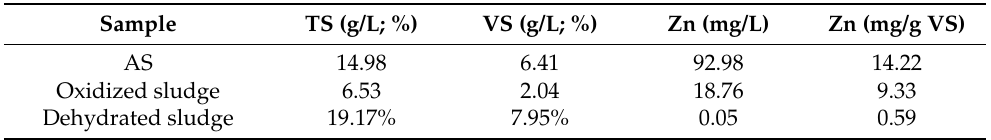
Table 1. Total solids (TS), volatile solids (VS), and Zn content of the three sewage sludge samples considered in this